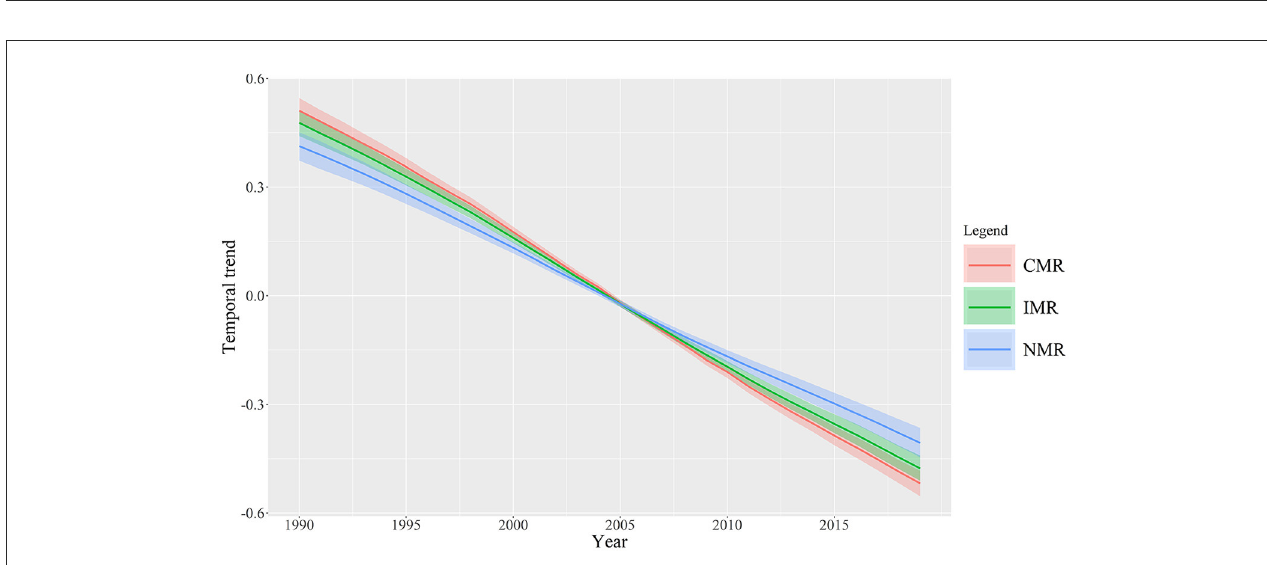
FIGURE8 Overall temporal trends of NMR, IMR, and CMR with 95% CI (the posterior medians of b 0 t + v t ) during the study period